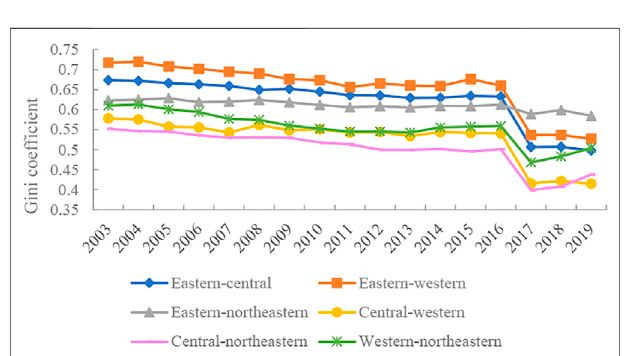
FIGURE 8 | Changing trends of the interregional Gini coef fi cient of carbon emission.